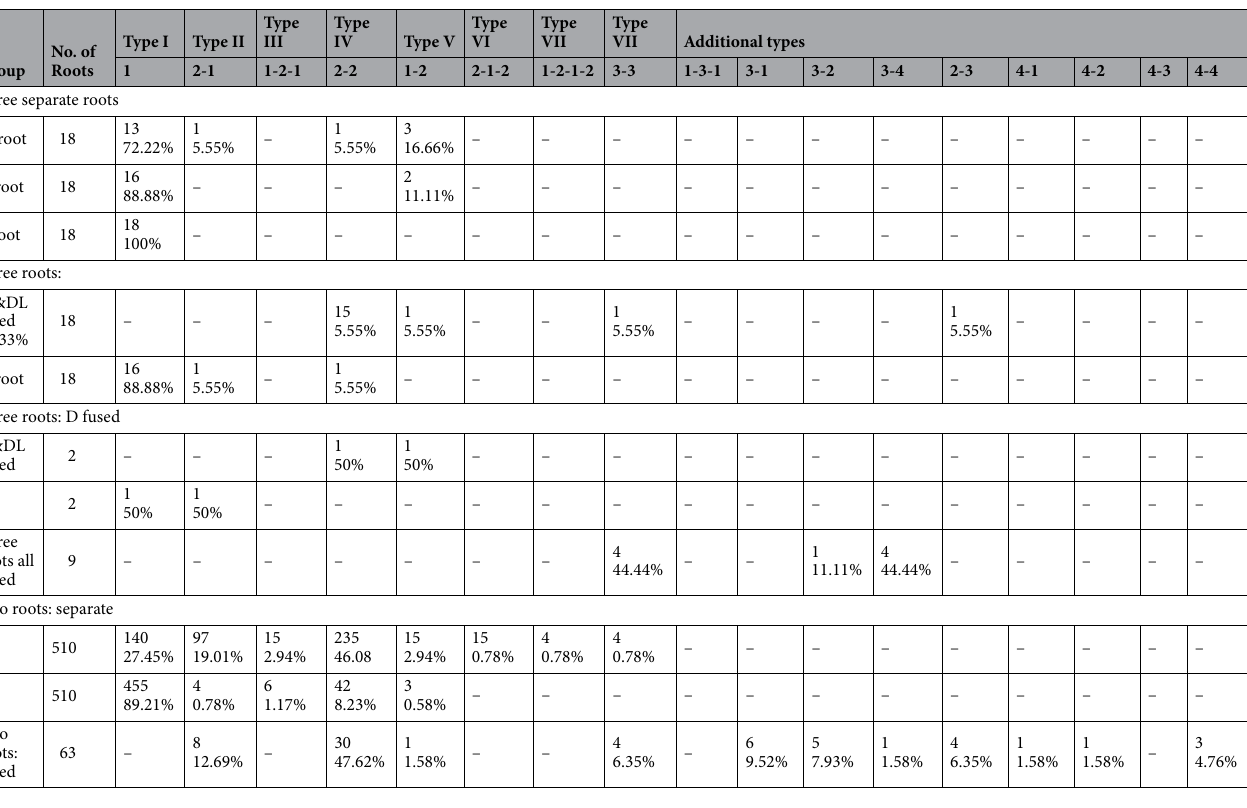
Table 4. Number and percentage of the common canal system types in mandibular third molars.